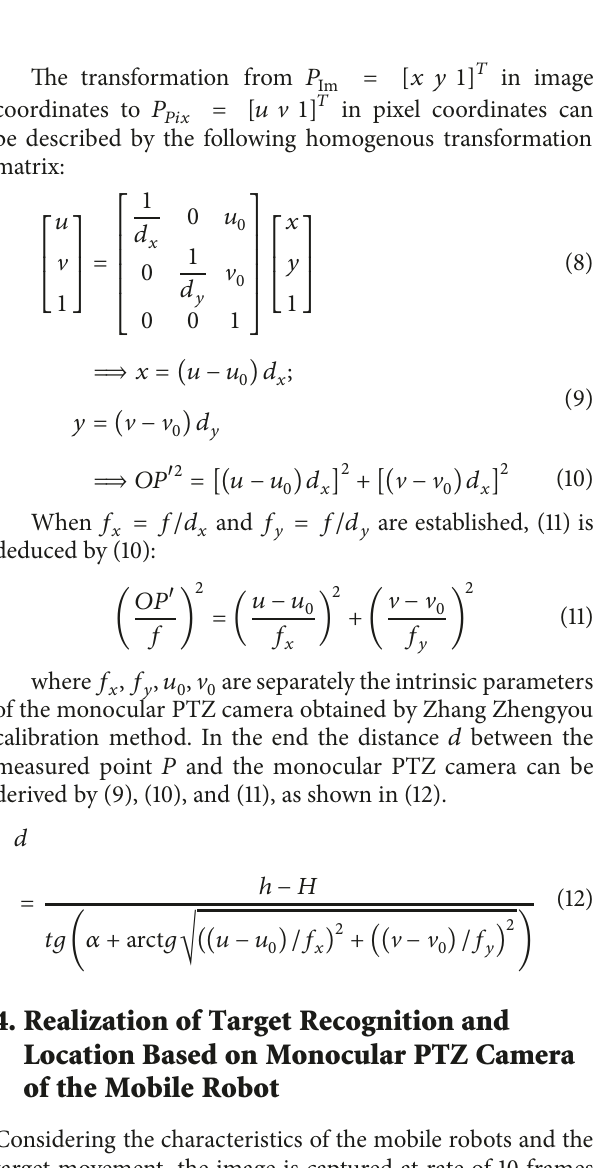
The transformation from 𝑃 Im = [𝑥 𝑦 1]